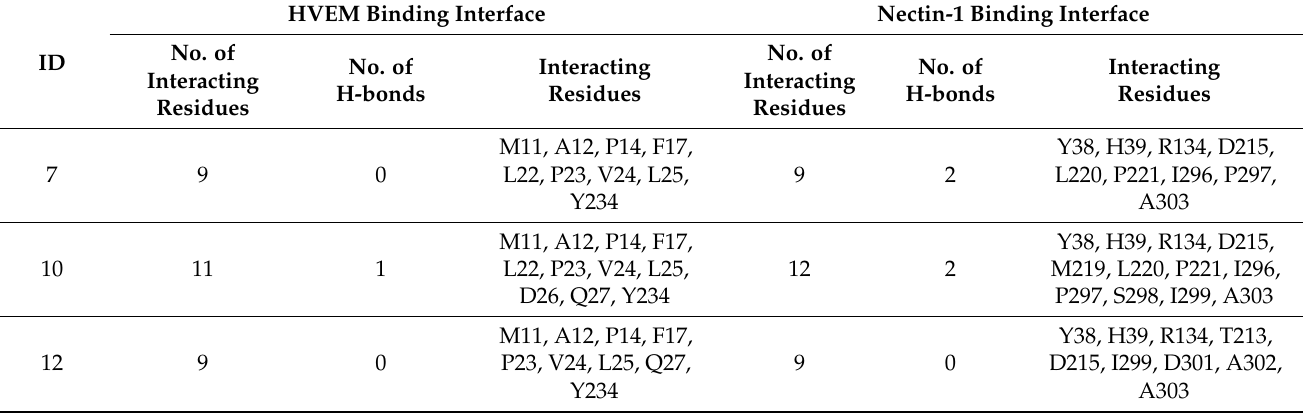
Table 2. Predicted interactions between (herpes virus entry mediator) HVEM and nectin-1 binding interfaces of glycoprotein D and compounds selected for in vitro